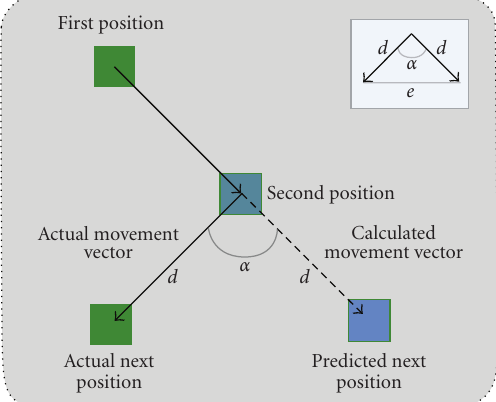
Figure 12: Warping in movement